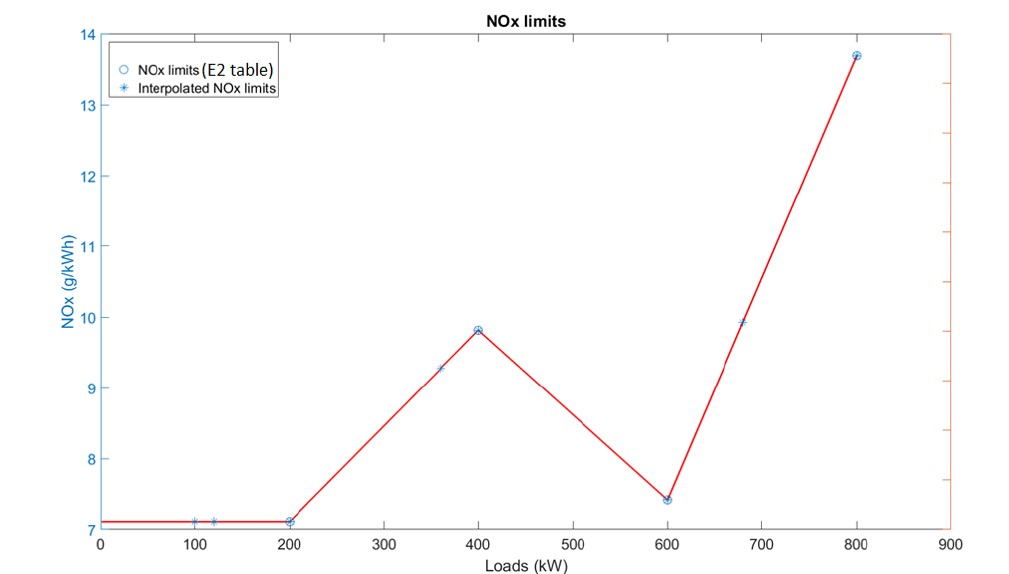
Figure 11. Interpolation of NO x limits within the power range.